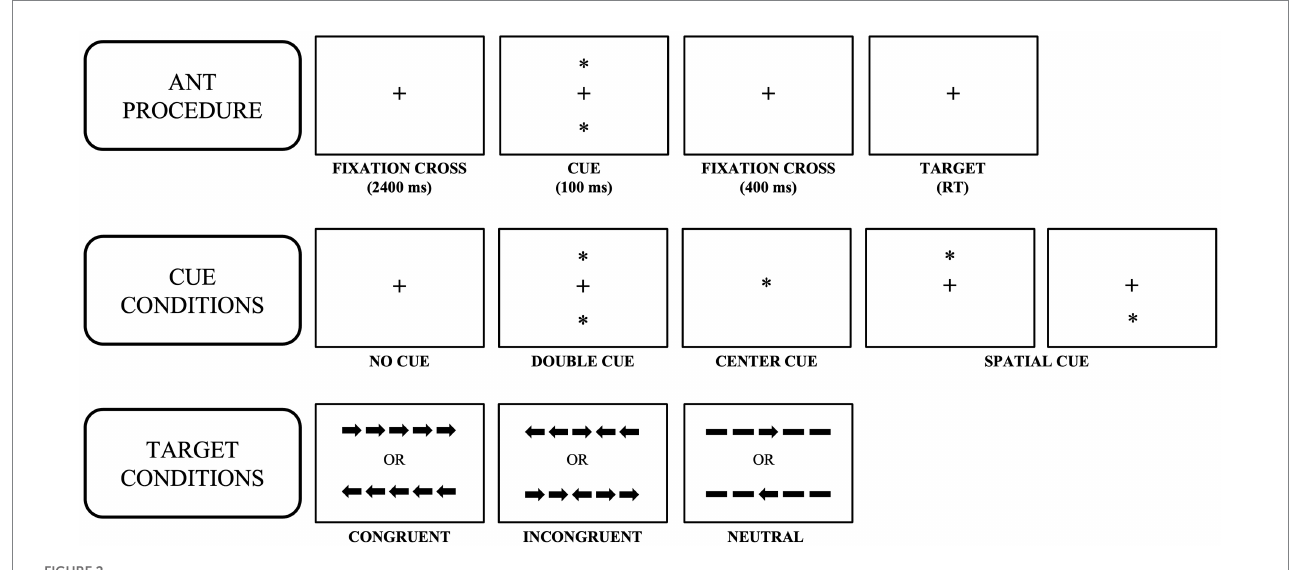
FIGURE 2 The Attention Network Test (ANT) procedure, cues, and